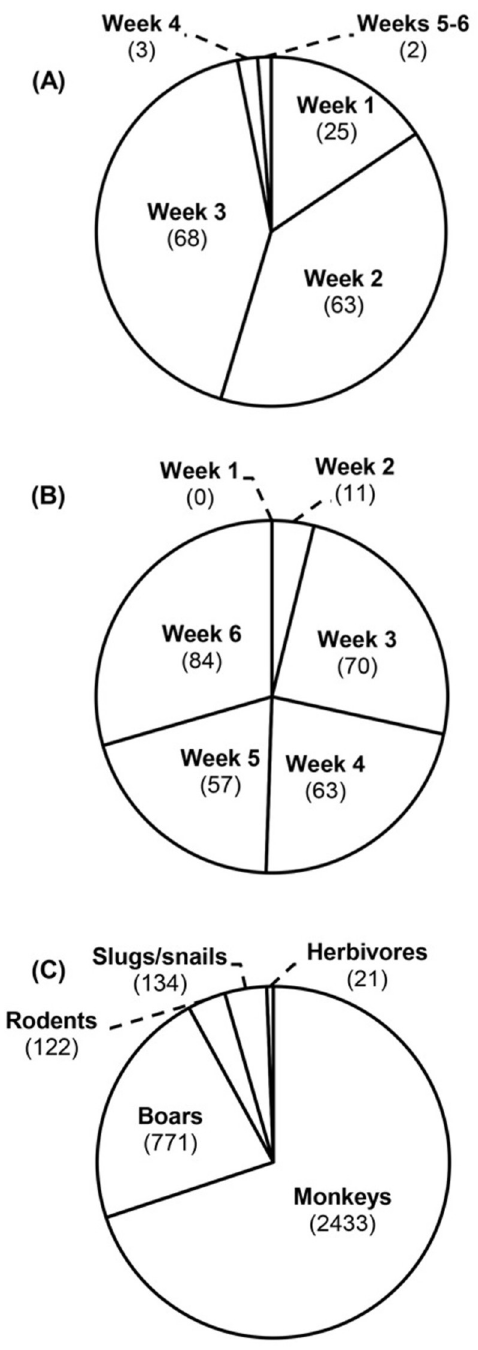
Fig 5. Slug/snail, borer and mammal predation patterns. A. Slug/snail attack in clump 58 (161 hits) (details in S9 Table in S1 File), B. Borer attack in clump 58 (285 hits) (details in S11 Table in S1 File), C. Predator attack in clump 359 (3481 hits) (details in S10 Table in S1